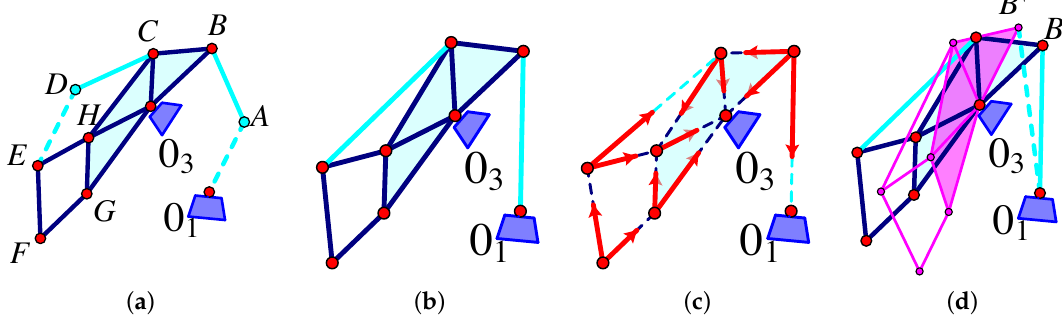
Figure 32. We can convert the backhoe to a pinned framework with two dotted pistons which represent possible drivers of a motion ( a ). If we freeze these pistons (dashed edges) at vertices A , D by fixed bars across the vertex ( b ) this becomes pinned isostatic. ( c ) shows the unique 2-directed orientation. ( d ) shows the motion if the piston 0 1 B is made